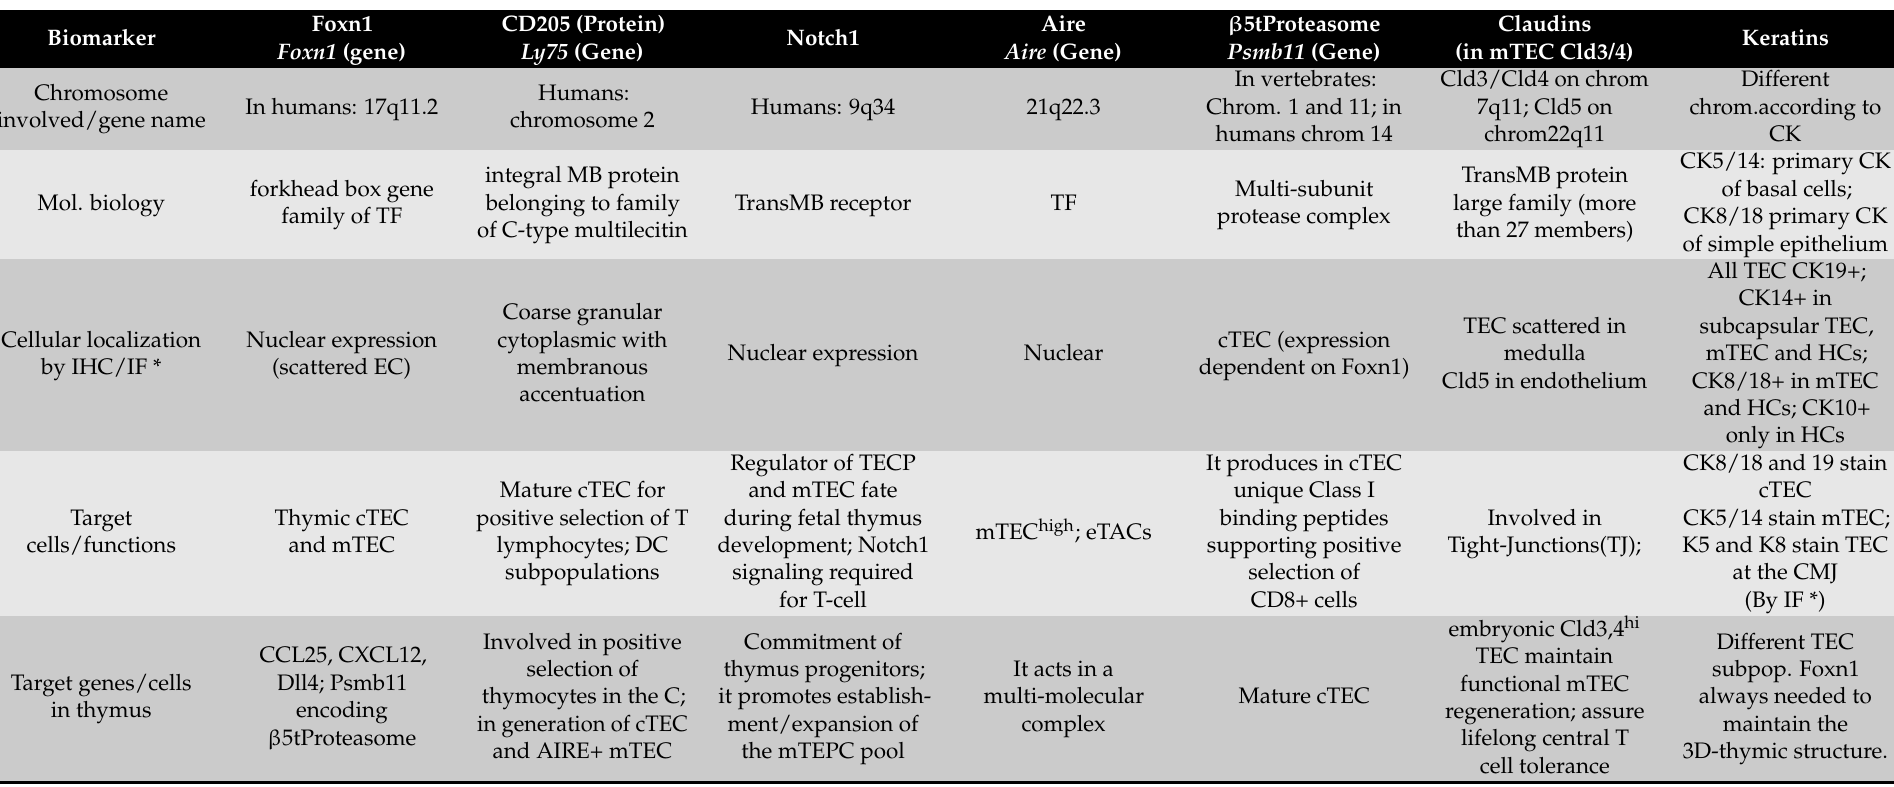
Table 1. Main genetic, cellular and available clinical characteristics of selected genes involved in Thymic development, in the pathogenesis of autoimmune disease and in